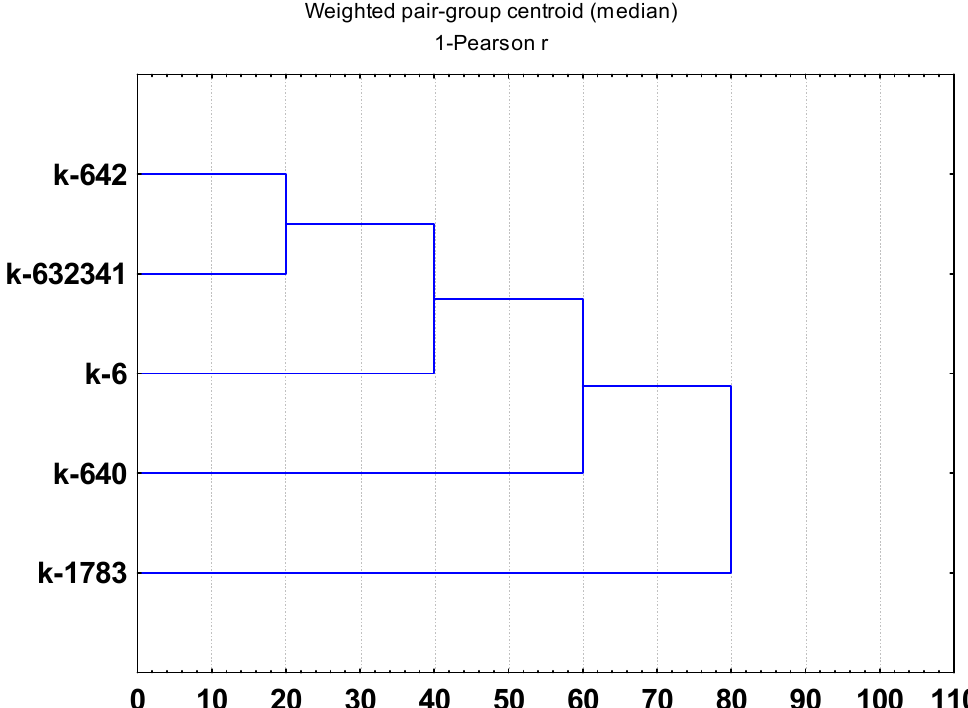
Figure 3. Dendrogram WPGMC (Median Clustering or Weighted Pair Group Method with Centroid Averaging), plotting on the basis of a comparative analysis of substances identified in V. unguiculata seeds.